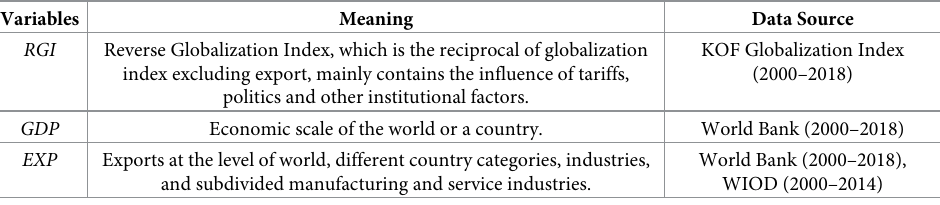
Table 1. Variable interpretation and data